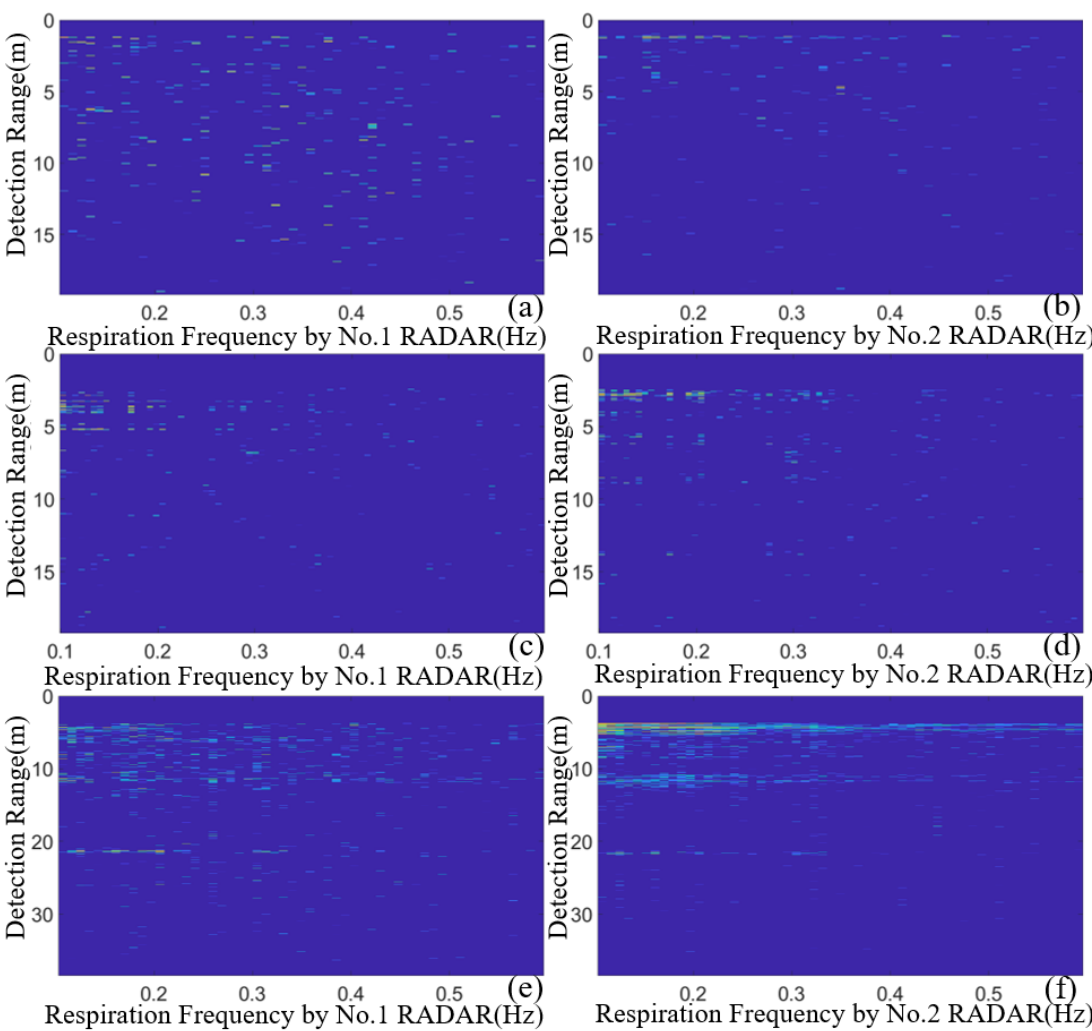
Figure 7. The output range-frequency images using the normal fast Fourier transform (FFT)-based respiration detection methods using the echoes from a single radar. ( a , b ) Type-I experimental results. ( c , d ) Type-II experimental results. ( e , f ) Type-III experimental results.